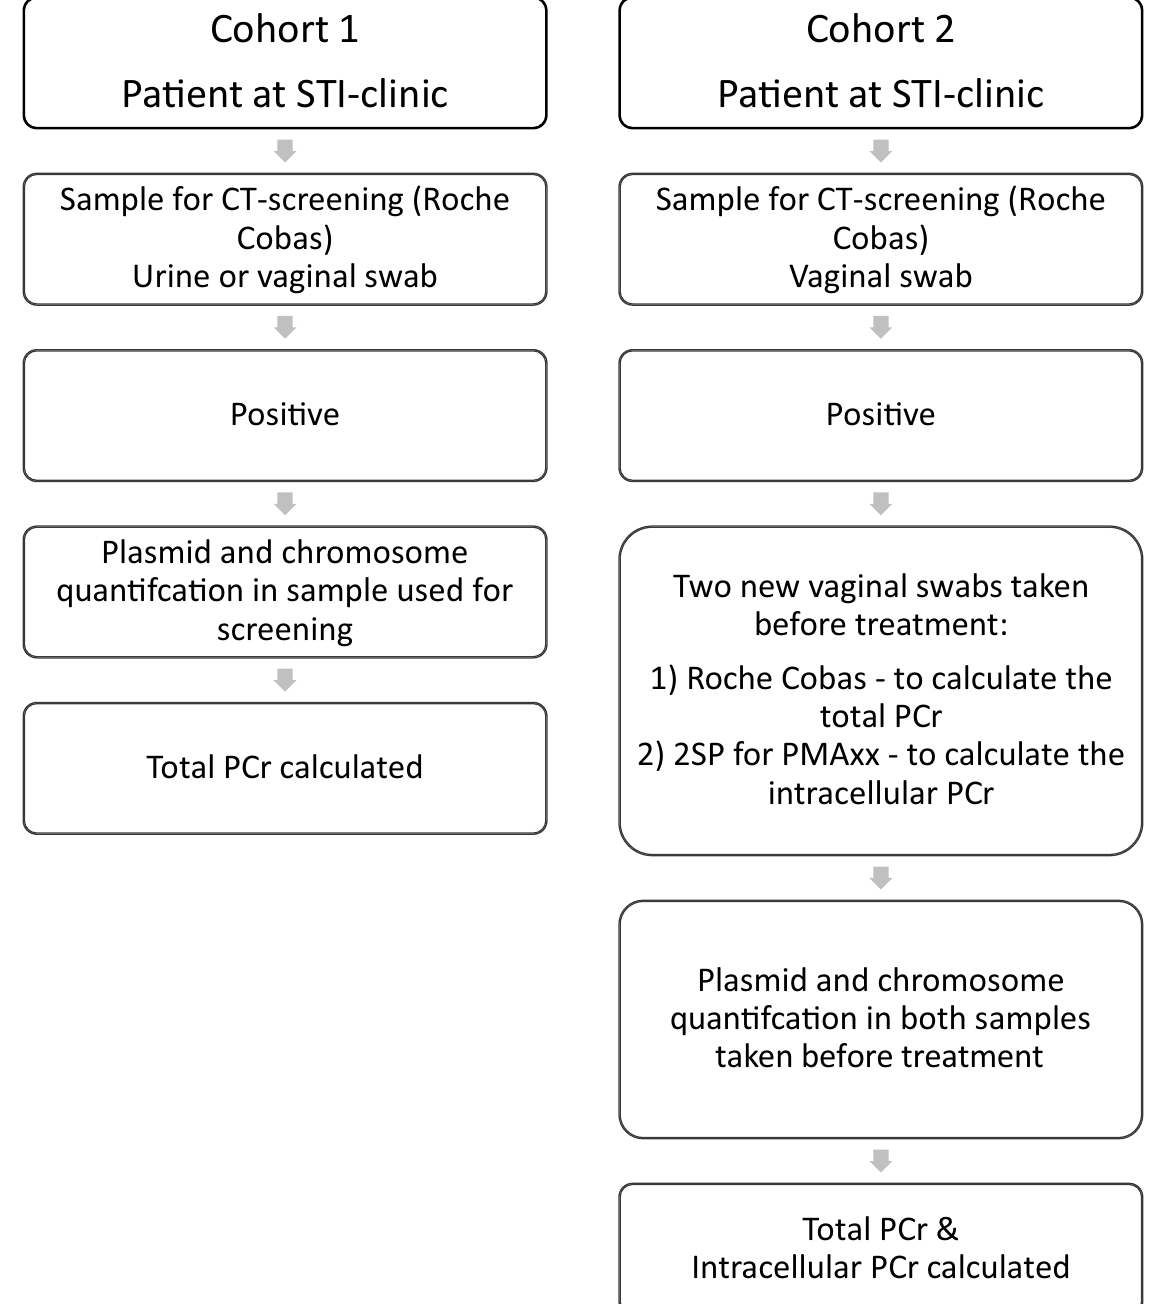
Figure 3. Flow-chart of patient inclusion in cohort 1 and cohort